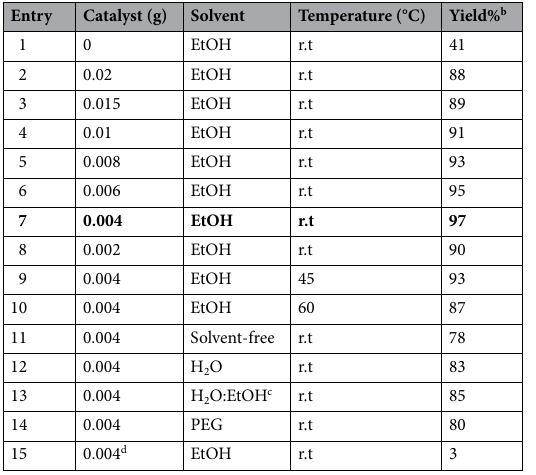
Table 7. Optimization of reaction condition for the synthesis of tetrahydrobenzo[b]pyran a . a 4-Chlorobenzaldehyde (1 mmol), malononitrile (1 mmol), dimedone (1 mmol), 30 min. b Pure yield. c Ratio: 2:1 mL. d The reaction catalyzed by HMS/Pr-PTSC. Significant values are in